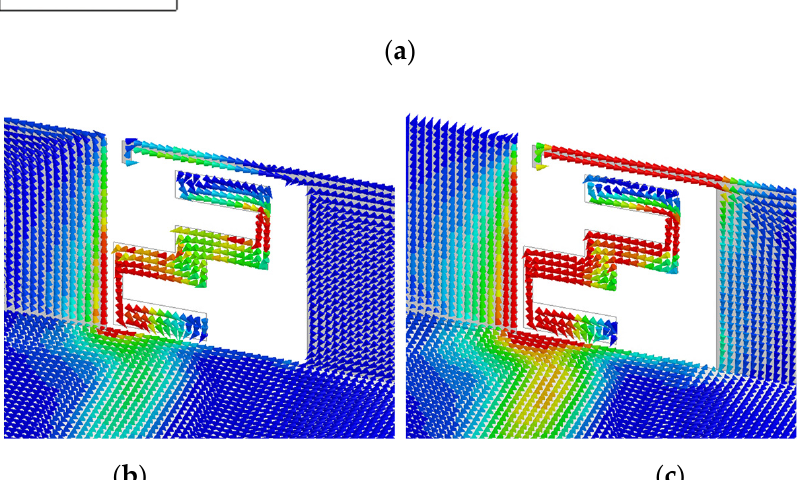
Figure 3. Simulated surface current distribution at ( a ) 3.5 GHz, ( b ) 4.9 GHz, and ( c ) 5.5 GHz.